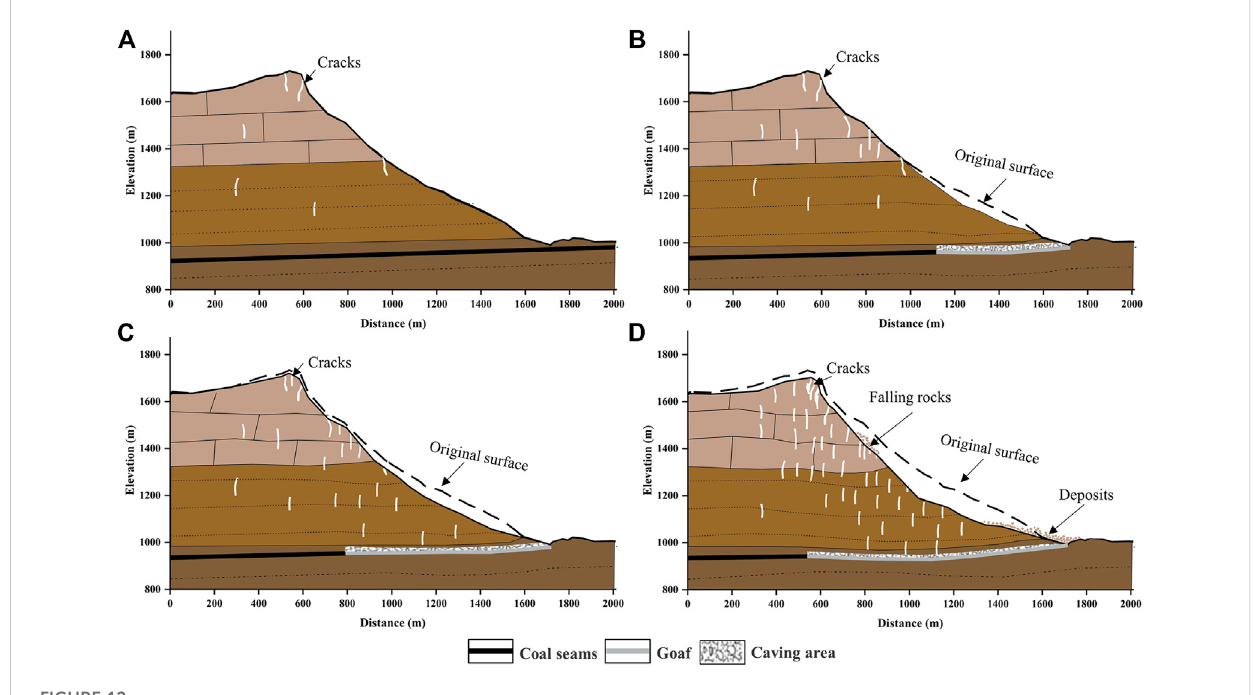
FIGURE 12 The failure process of the Pingdi